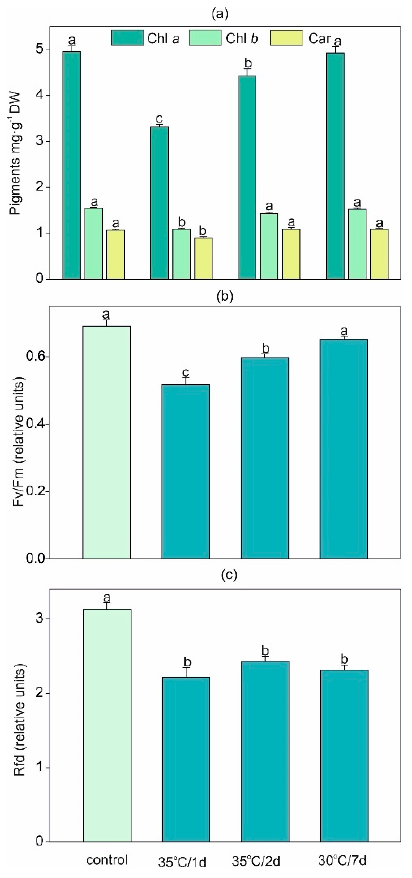
Figure 1. Photosynthetic pigment content: ( a ) chlorophyll a , b and carotenoids and chlorophyll fluorescence parameters: ( b ) Fv/Fm—maximum quantum yield of PSII/maximal fluorescence in the dark-adapted state, respectively; ( c ) Rfd—ratio of fluorescence decrease in H. sosnowskyi exposed to heat stress. Data are means ± SE ( n = 4 for pigments, n = 8 for fluorescence parameters). Values followed by the same letter(s) are not significantly different according to Tukey’s test ( p < 0.05). Both F0 and Fm showed an increase only after 1 d of heat stress with recovery to the control level under longer exposure (Supplementary Materials Figure S2a,b). F0 is a conve- nient parameter for monitoring the high-temperature impact on PSII inactivation [16].